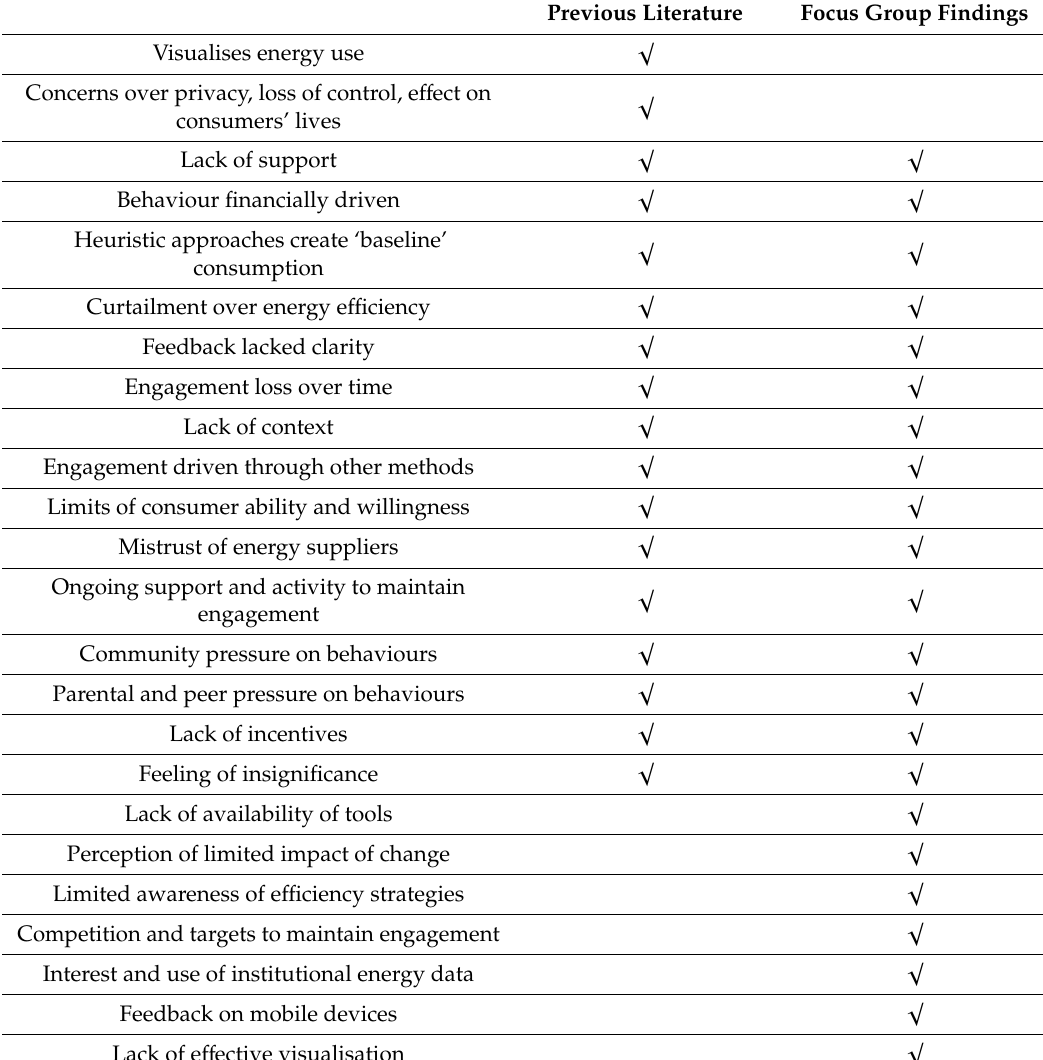
Table 2. Highlights where the findings of this paper reinforce previous research and where new contributions are